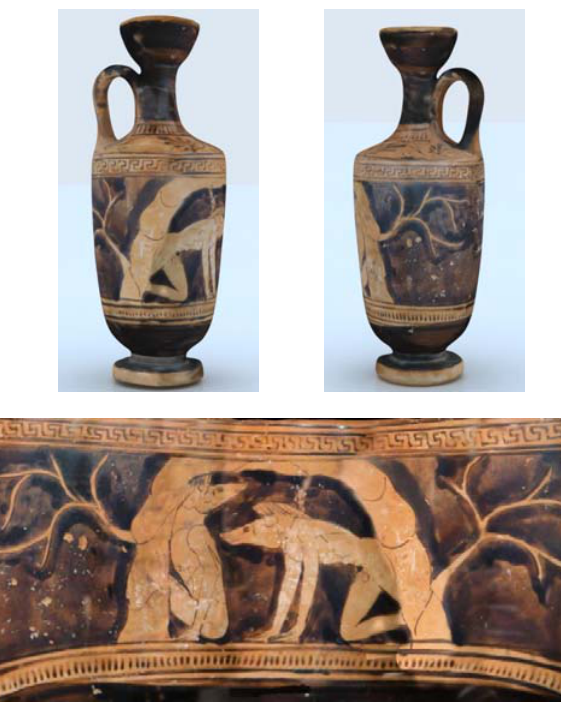
up) and the development of Fig. 12. The final 3D model ( texture map of the carving (bottom) of the smaller lekythos